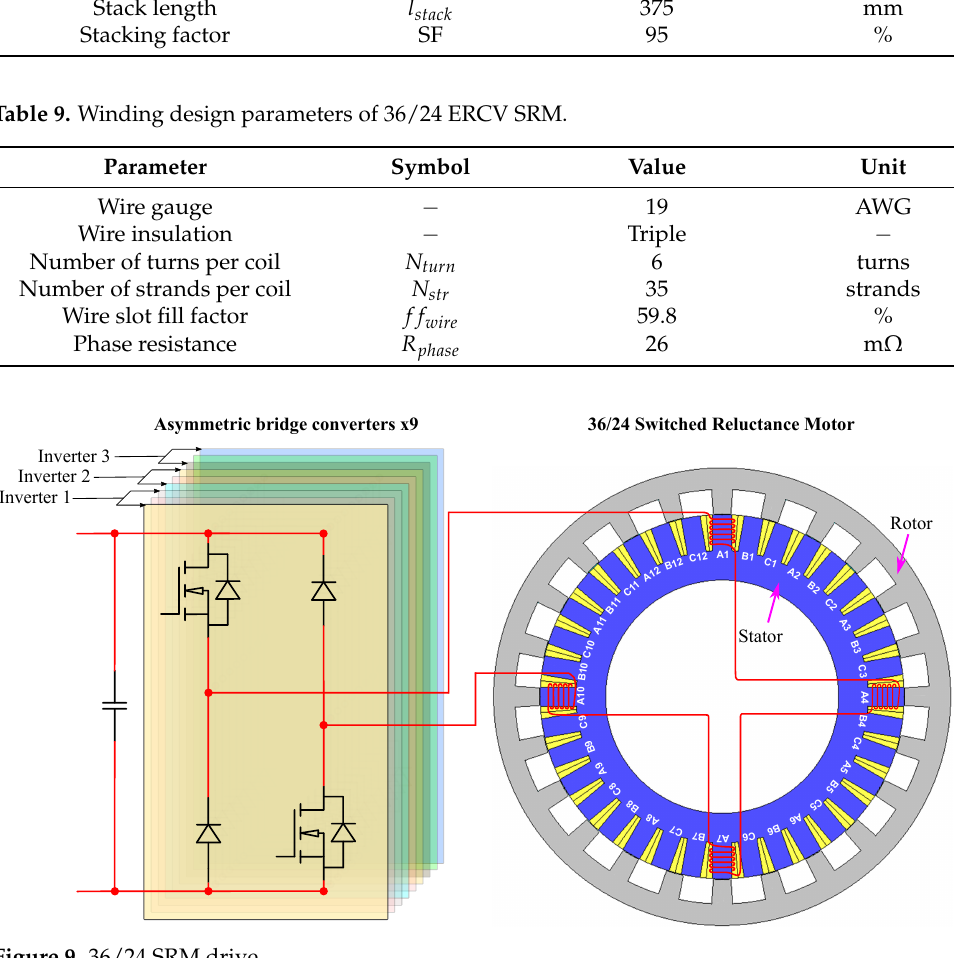
Figure 9. 36/24 SRM